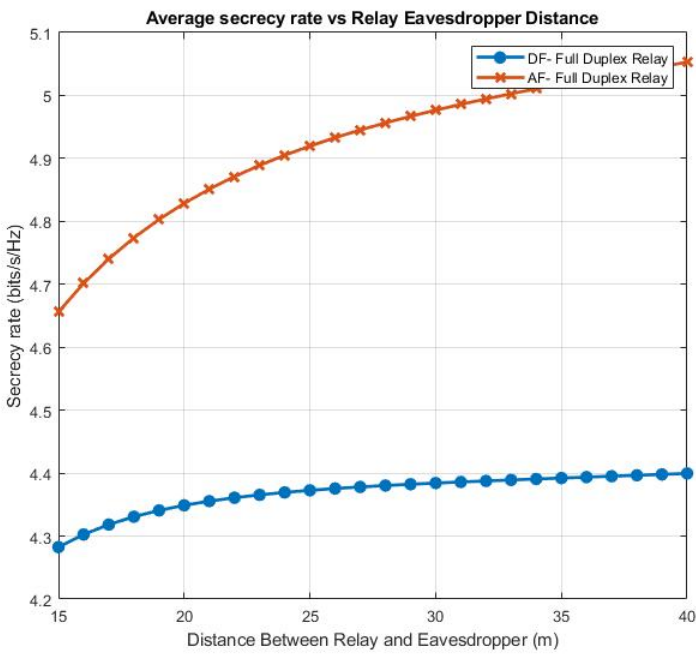
Figure 10. Secrecy Rate vs. d R 2 E for the EH PS System.